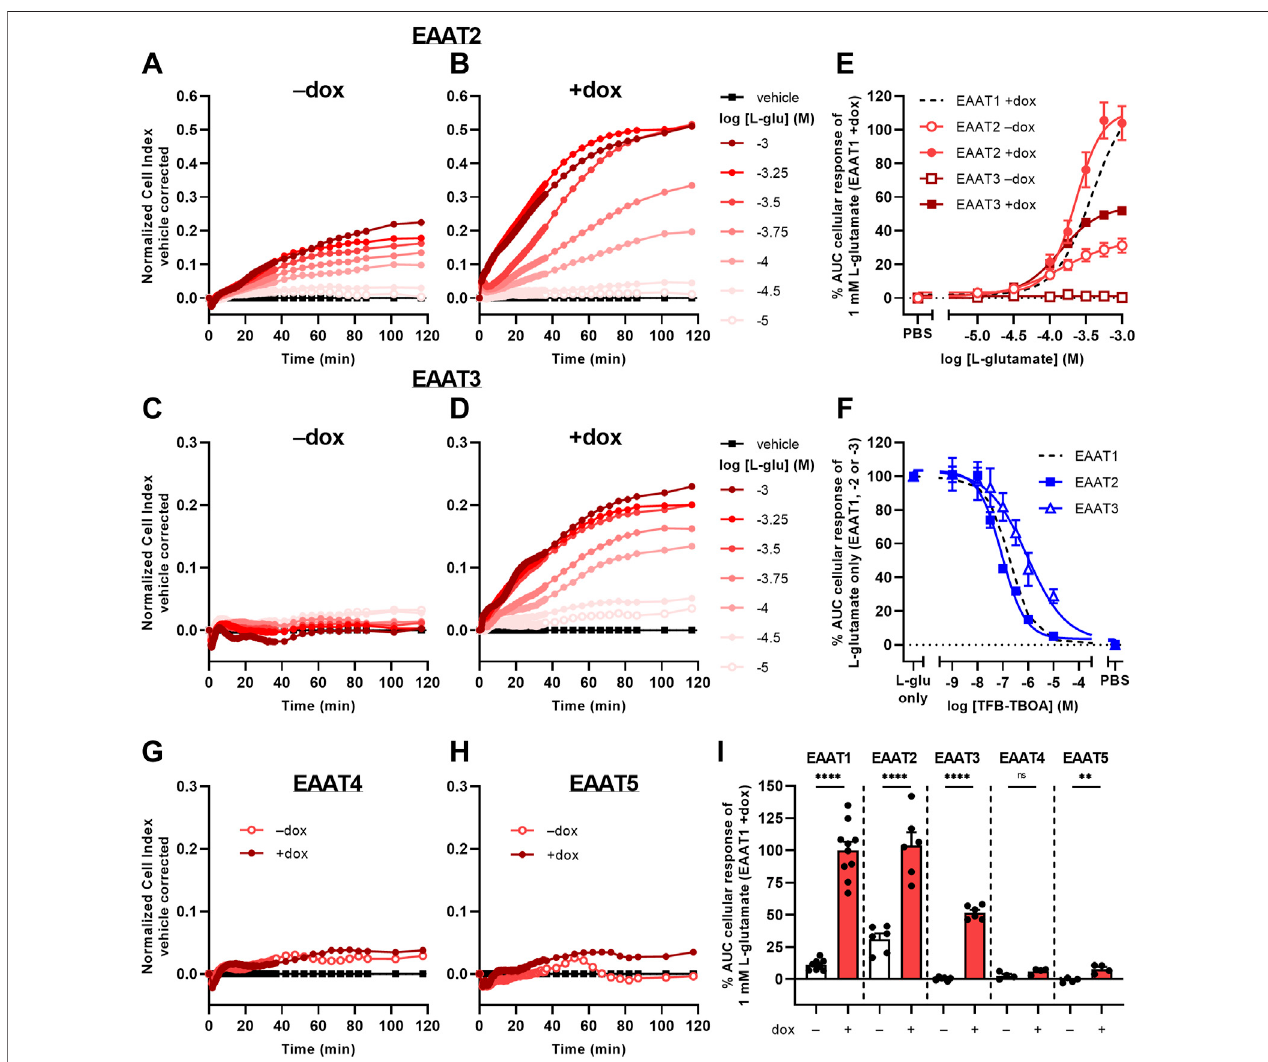
FIGURE 6 | L-glutamate-induced cellular responses on JumpIn-EAAT2 and JumpIn-EAAT3 cells. (A – D , G , H) Vehicle-corrected nCI traces of JumpIn-EAAT2 (A , B) , JumpIn-EAAT3 (C , D) , JumpIn-EAAT4 (G) and JumpIn-EAAT5 (H) cells in the absence ( − dox) or presence (+dox) of doxycycline stimulated with vehicle (PBS) or L-glutamate(L-glu),shownasthemeanofarepresentativeexperimentperformedinduplicate. (E) Combinedconcentration-responsecurvesofL-gluonJumpIn-EAAT2 and JumpIn-EAAT3cells(±dox).Dataarenormalized totheresponseof1 mML-gluonJumpIn-EAAT1+doxcells(dataisderivedfrom Figure2D andshownasa black dotted line). (F) Combined concentration-inhibition curves of TFB-TBOA on +dox JumpIn-EAAT2 and JumpIn-EAAT3 cells pretreated for 1 h with vehicle (PBS/ DMSO) or increasing concentrations of TFB-TBOA and subsequently stimulated with a submaximal concentration (316 µM) of L-glu. Data are normalized to the response of 1 mM L-glu (JumpIn-EAAT1, data is derived from Figure 2E and shown as a black dotted line) or 316 μ M L-glu (JumpIn-EAAT2 and -EAAT3). (I) Cellular response of 1 mM L-glu on − dox and +dox JumpIn cells for all EAAT subtypes. Data on JumpIn-EAAT1, -EAAT2 and -EAAT3 cells were derived from Figure 2D and Panel 6E . Cellular response is expressed as the net AUC of the fi rst 120 min after substrate stimulation. Data are shown as the mean ± SEM of at least three individual experiments each performed in duplicate. ns = not signi fi cant, ** p < 0.01, **** p < 0.0001; unpaired two-tailed Student ’ s